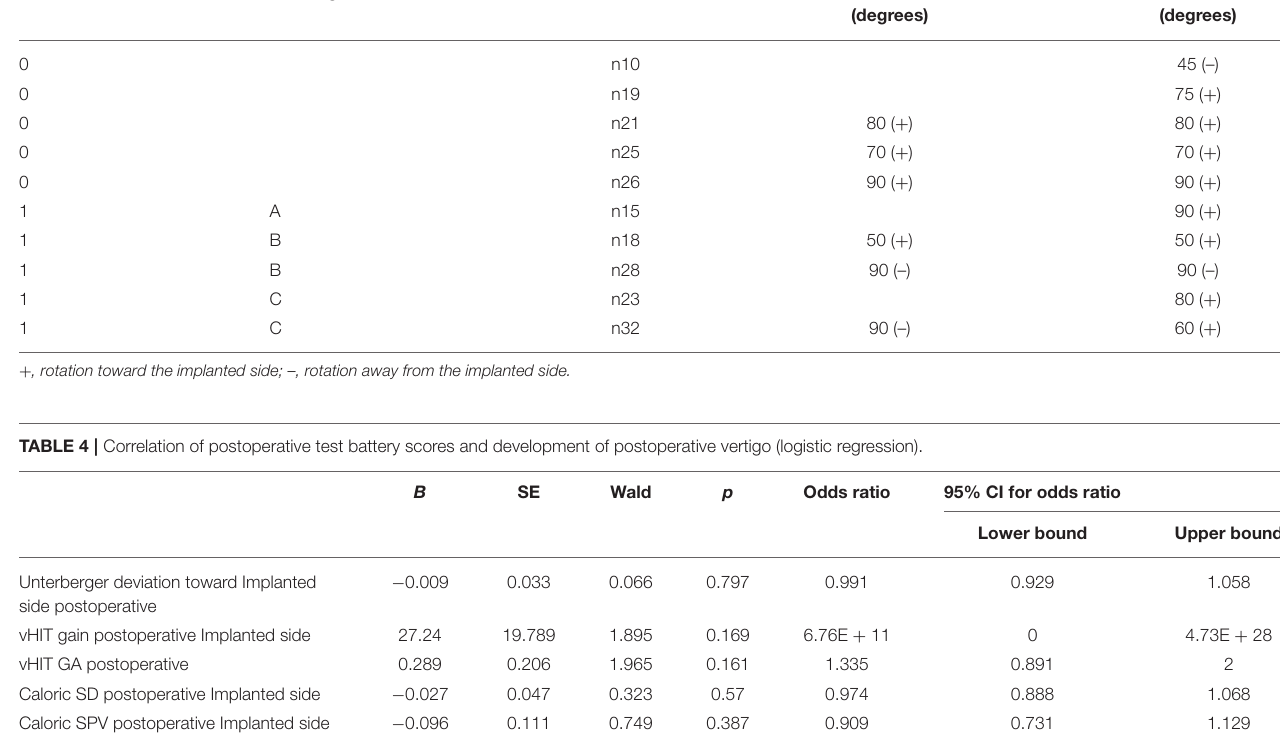
TABLE 3 | Unterberger test, cases with conspicuous results only, pre- and post-operative (for information on vertigo group and origin of vertigo, see Table 2 ). Vertigo group